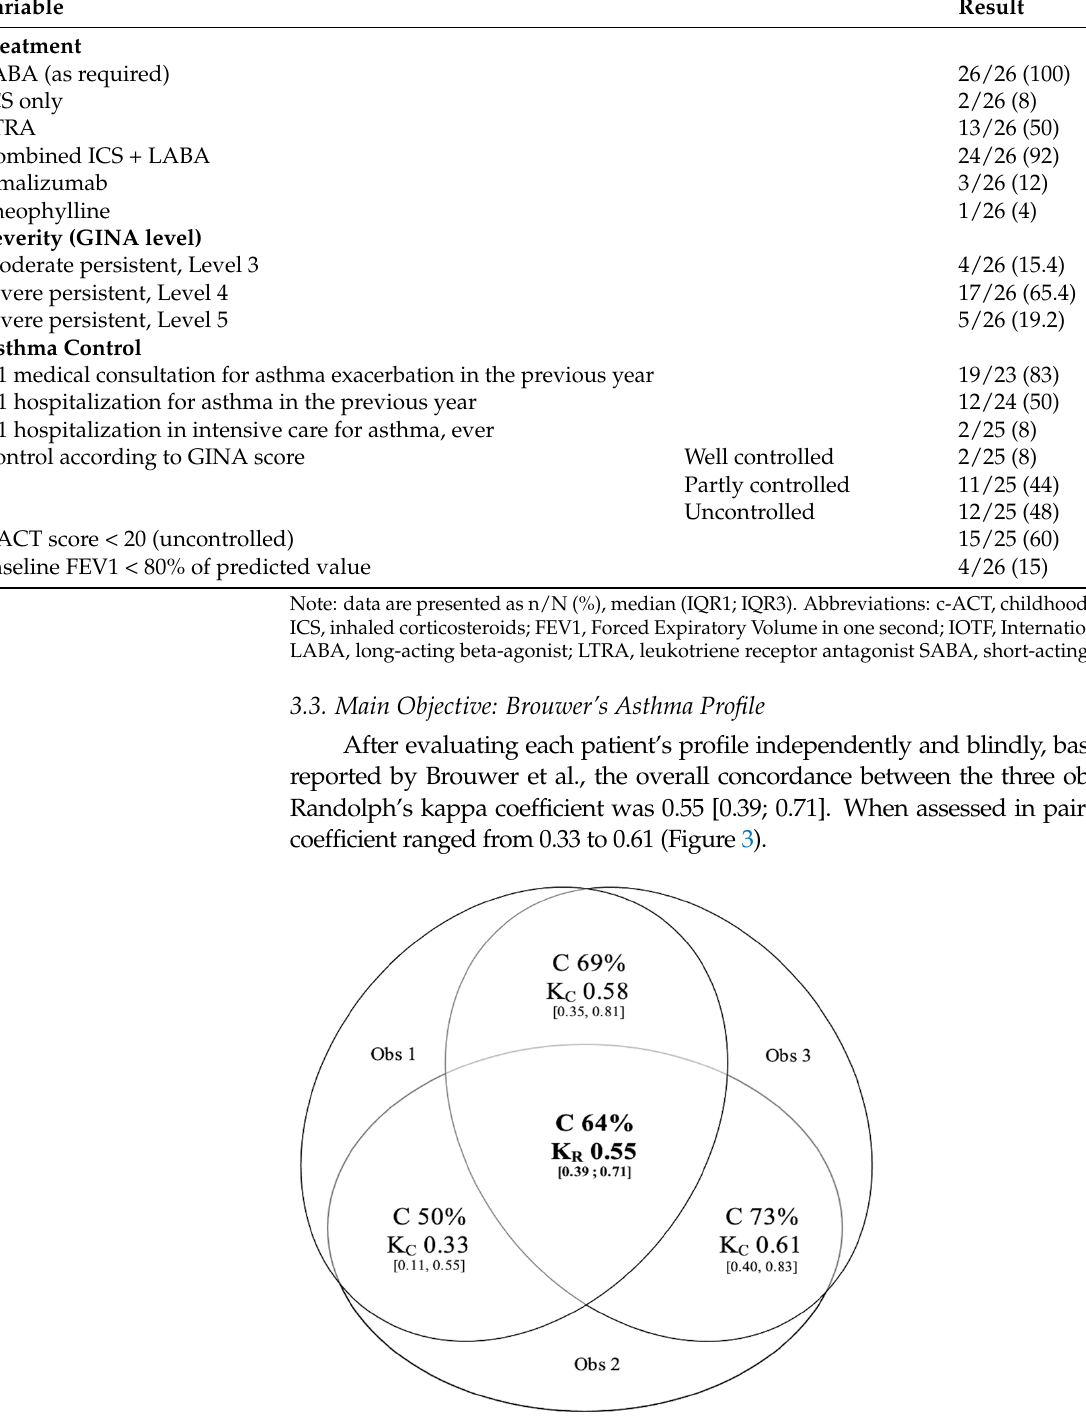
Figure 3. Concordance in the evaluation of the perception profile of the 26 patients between the three observers before the Delphi approach. Abbreviations: Obs, observer; C, concordance (%); K C , Cohen’s kappa coefficient [IC 95%]; K R , Randolph’s kappa coefficient [IC 95%]. Using a Delphi approach (consensus among observers), the final overall agreement was 97% with a Randolph’s kappa coefficient of 0.97 (0.91; 1.00). The percentage of